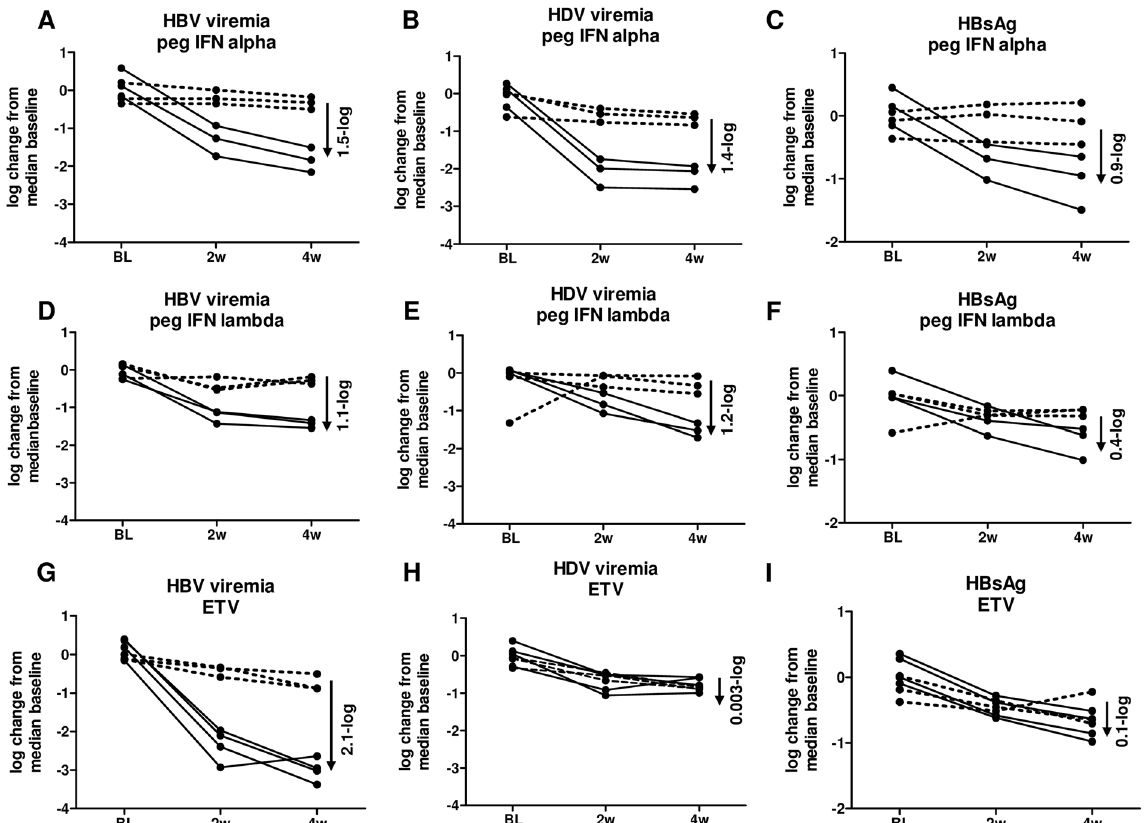
Figure 1. Viremia changes upon treatment. Depicted is HBV viremia ( A,D,G ), HDV viremia ( B,E,H ) and levels of circulating HBsAg ( C,F,I ) as fold change from median baseline levels from each mouse, which was either treated (solid line) with peg-INF α (25ng/g body weight) ( A–C ), peg-INF λ (25ng/g body weight) ( D–F ) or ETV (1 µ g/ml supplemented in drinking water) ( G–I ) or left untreated (dashed line). Baseline levels were obtained at time-points where HBV/HDV co-infection was stable; the median baseline level was calculated from all mice (treated and untreated) for each study. The fold reduction is shown on each graph as log-change and was calculated as median of the control versus median of the treated group at the end of